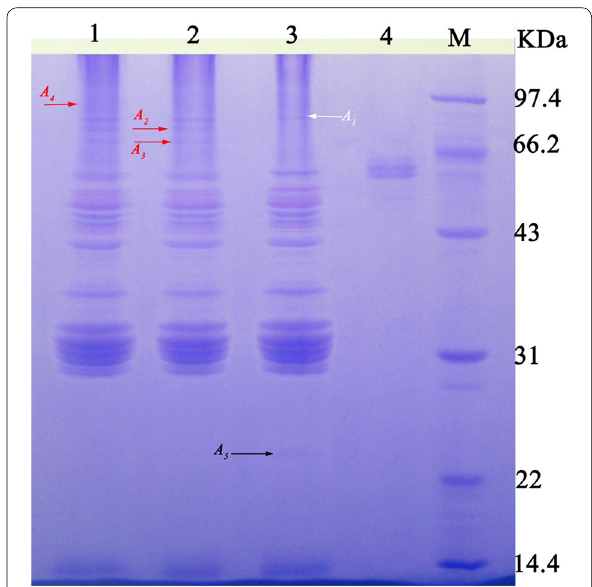
Fig. 5 SDS-PAGE analysis on the cross-linkage of flour proteins. Lanes: (1) flour treated with 2.0 U/g of laccase; (2) flour treated with 0.5 U/g of laccase; (3) the reference; (4) laccase; (M) the molecular weight marker. Major changes are illustrated with arrows (A 1 –A 5